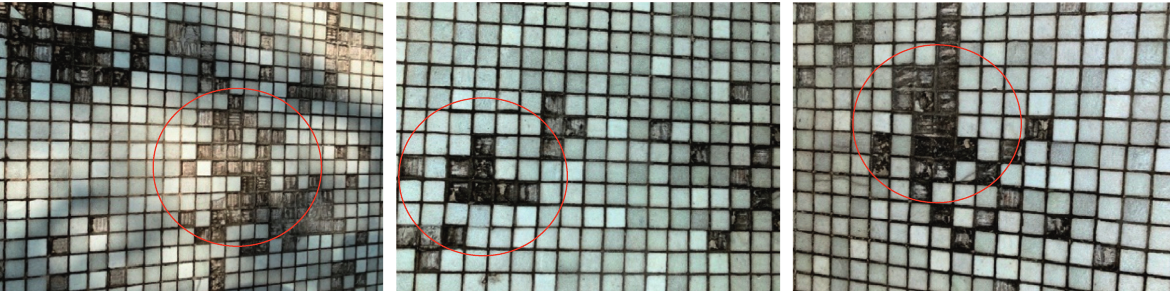
Figure 5: Spalling areas similar to defacement.